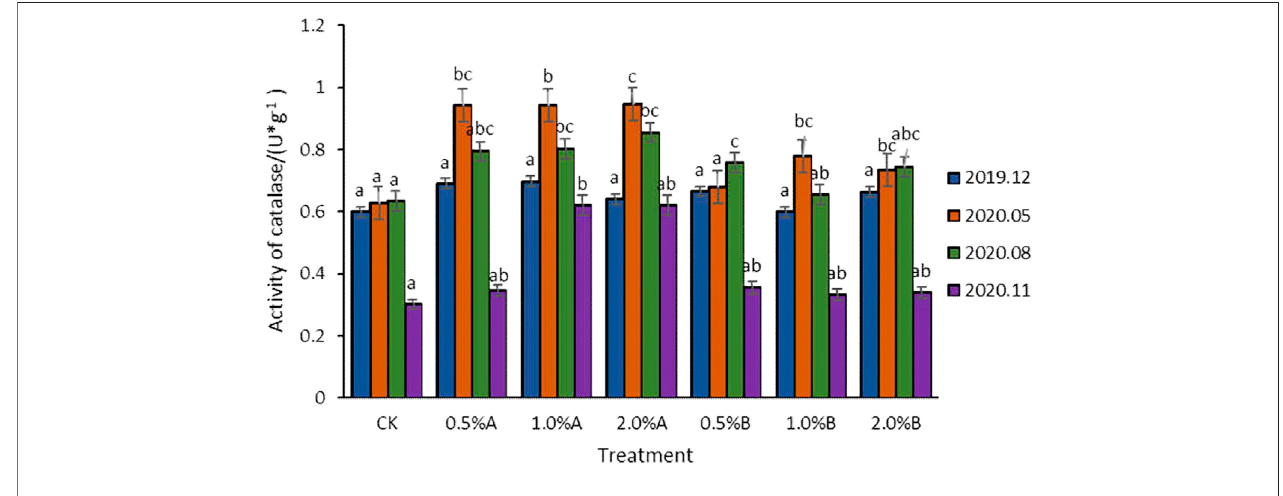
FIGURE 5 | Variation of catalase activity with time in each treatment.